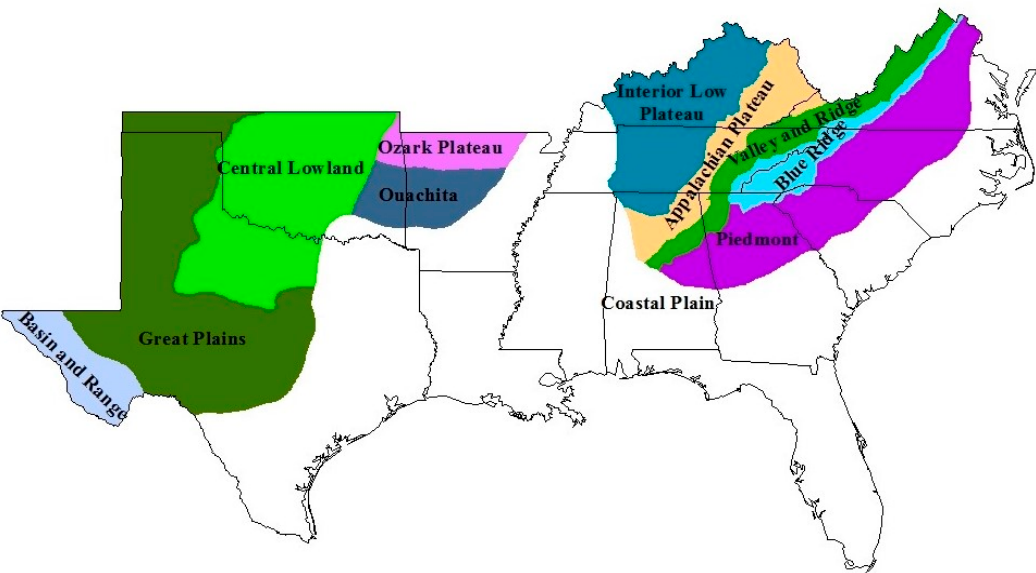
Figure 1. Physiographic regions of the southeastern U.S., including Piedmont. The Southern Piedmont region was selected for this study due to availability of forest operations research evaluating soil erosion and BMP implementation levels. Five southeastern states include areas within the Piedmont region.